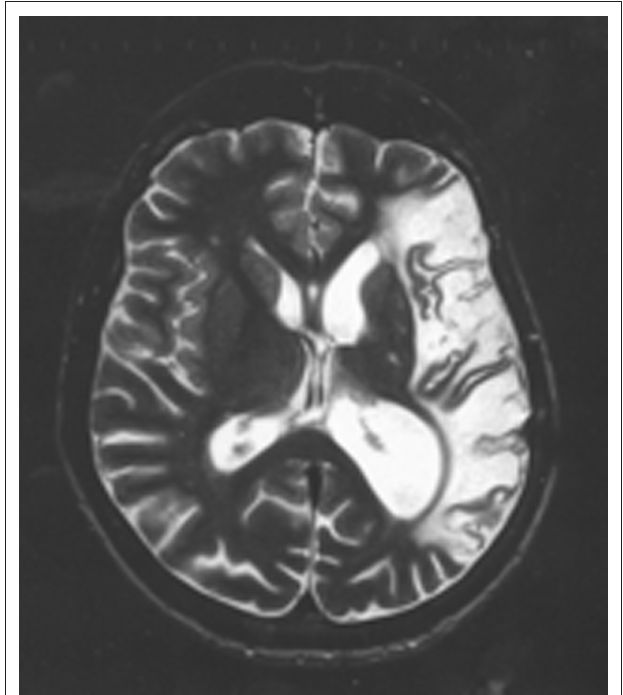
Figure 1 | An axial slice of an anatomical scan of one of the patients tested on a false belief task in Varley and Siegal (2000). Note the extensive damage in the left hemisphere, encompassing the whole cortical language network. The images are displayed following radiological convention which means that the left hemisphere is on the right side of the